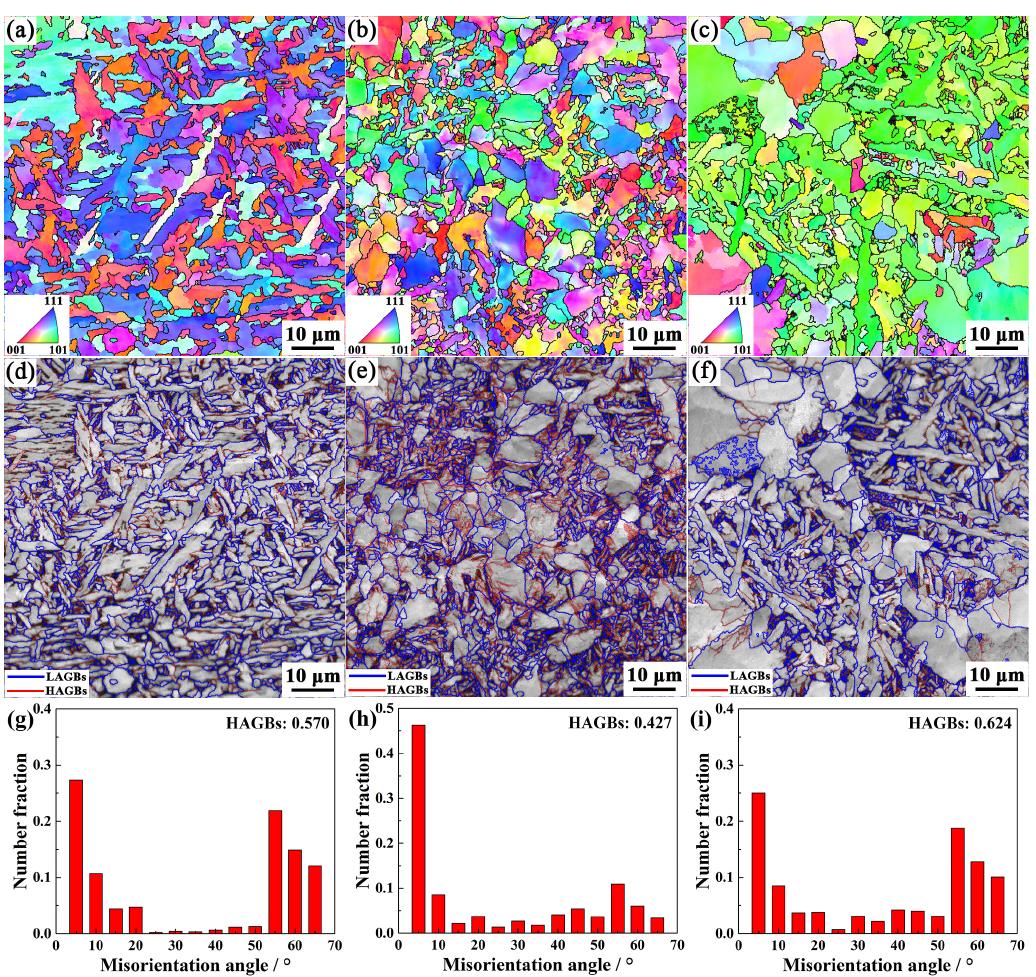
Figure 6: Crystallographic characteristics of the simulated CGHAZ at different t 8/5 : (a), (d) and (g) 30 s; (b), (e) and (h) 90 s; (c), (f) and (i) 180 s; (a)-(c) orientation image maps; (d)-(f) image quality maps with grain boundary misorientation distribution (LAGBs and HAGBs are indicated by red line and blue line, respectively); and (g)-(i) misorientation angle distribution histograms.